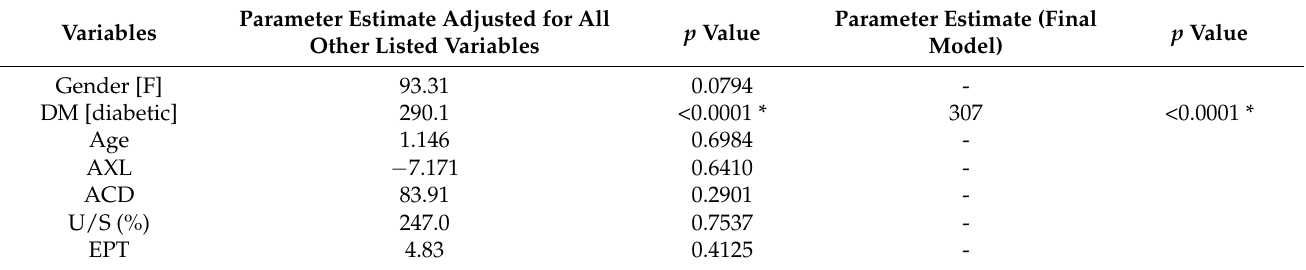
Table 3. Multiple regression model of the measured variables with the cell density